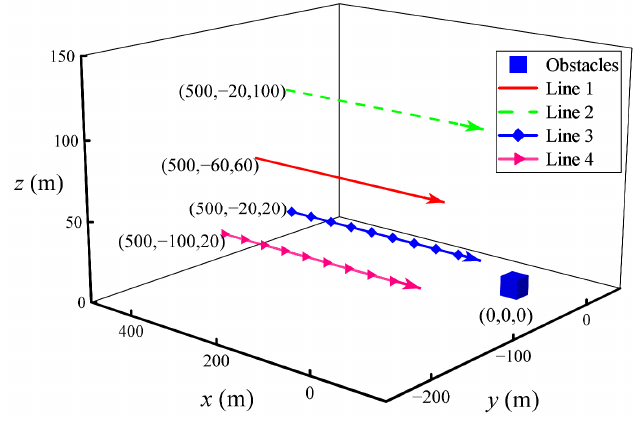
Figure 7. Schemes follow the same format.